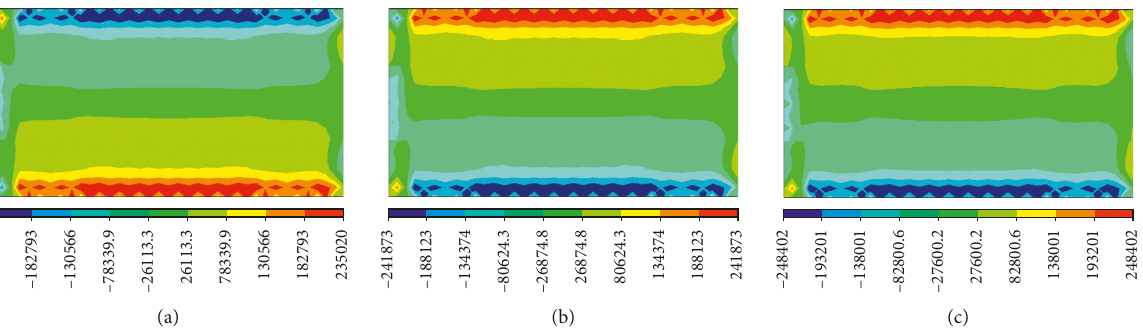
50%. (b) P 90%. (c) P 95%. (cid:31) (cid:31) (cid:31)